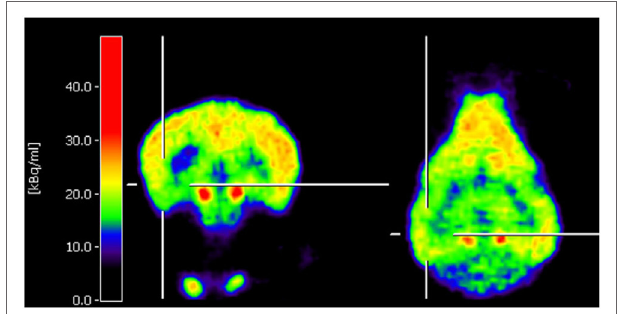
FiGURe 1 | Coronal and horizontal F-18-fluoro-deoxy-glucose positron emission tomography (PET) images from a 10.5-week-old puppy with juvenile epilepsy showing an area of hypometabolism in the left temporal lobe, indicated by the cross localizers. The hot scale represents radioactivity concentration (kBq/ml) [taken from Ref (25), permission from the copyright holder has been